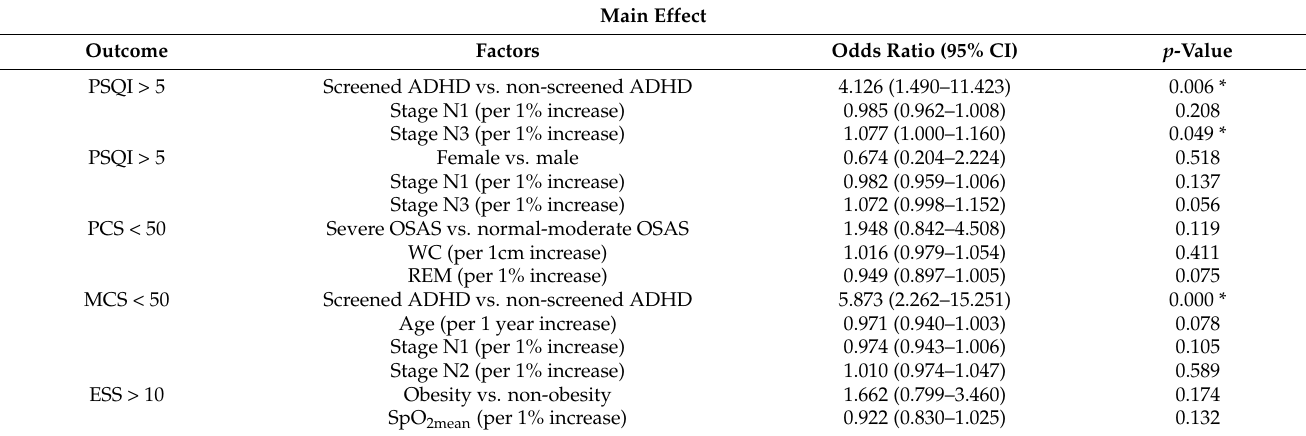
Table 4. The significant factors for self-reported HRQoL in the multiple logistic regression